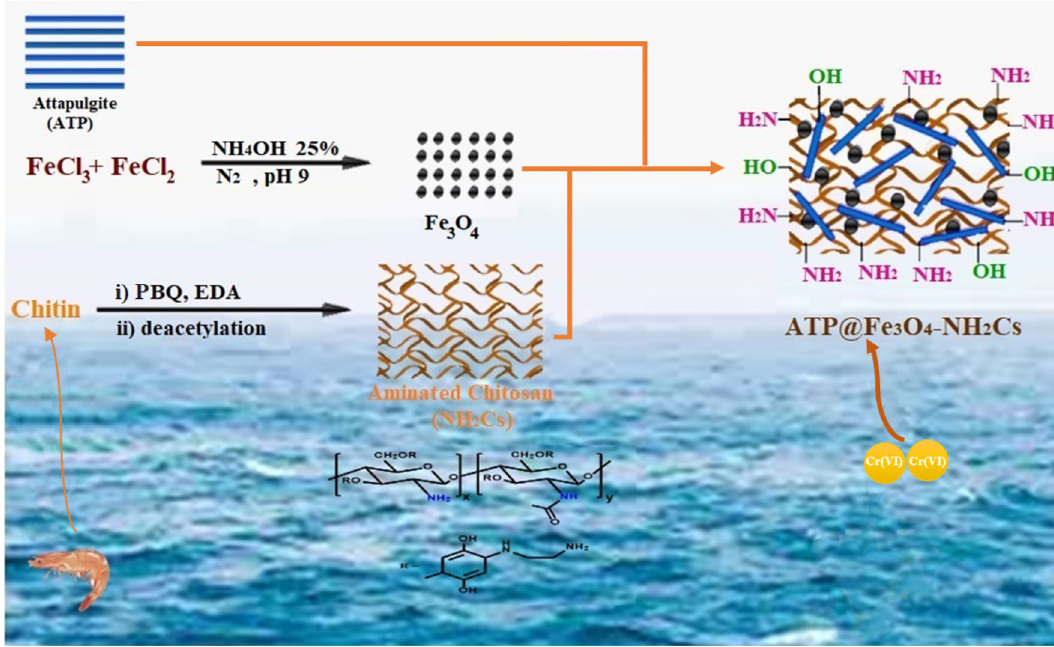
Figure 1. A schematic representation for the fabrication process of ATP@Fe 3 O 4 -NH 2 Cs magnetic